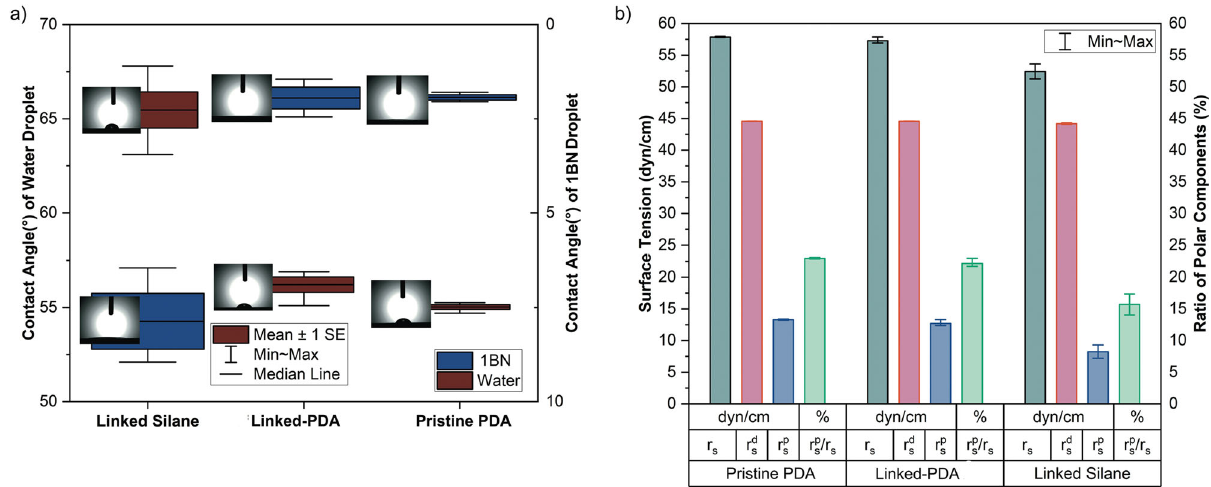
Fig. 8 a Contact angles and ( b ) surface properties of pristine PDA, linked-PDA and linked silane